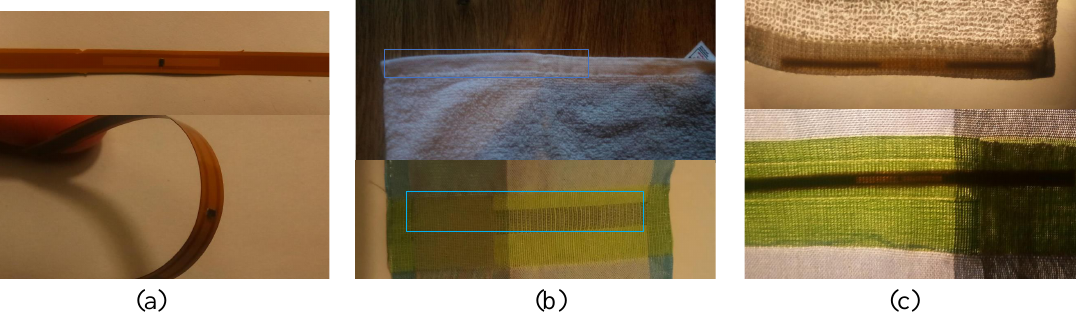
Figure 5. Photographs of the encapsulated RFID tags and the tags integration in textiles: ( a ) the Kapton-molded tag, ( b ) the concealed tag in a cotton towel (top) and a woven fabric (bottom), ( c ) the tags visible under high light